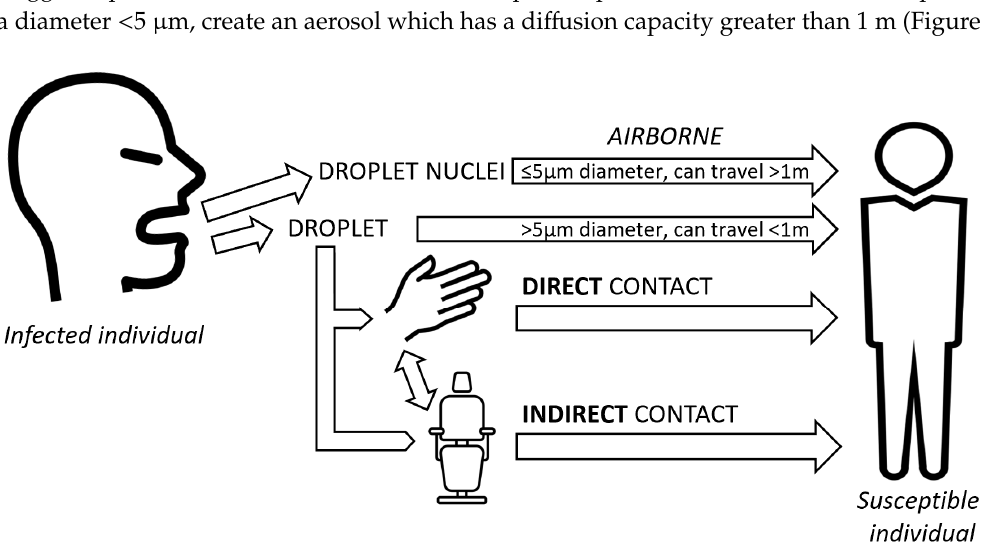
Figure 1. Severe Acute Respiratory Syndrome Coronavirus 2 (SARS-CoV-2) route of transmission of in healthcare